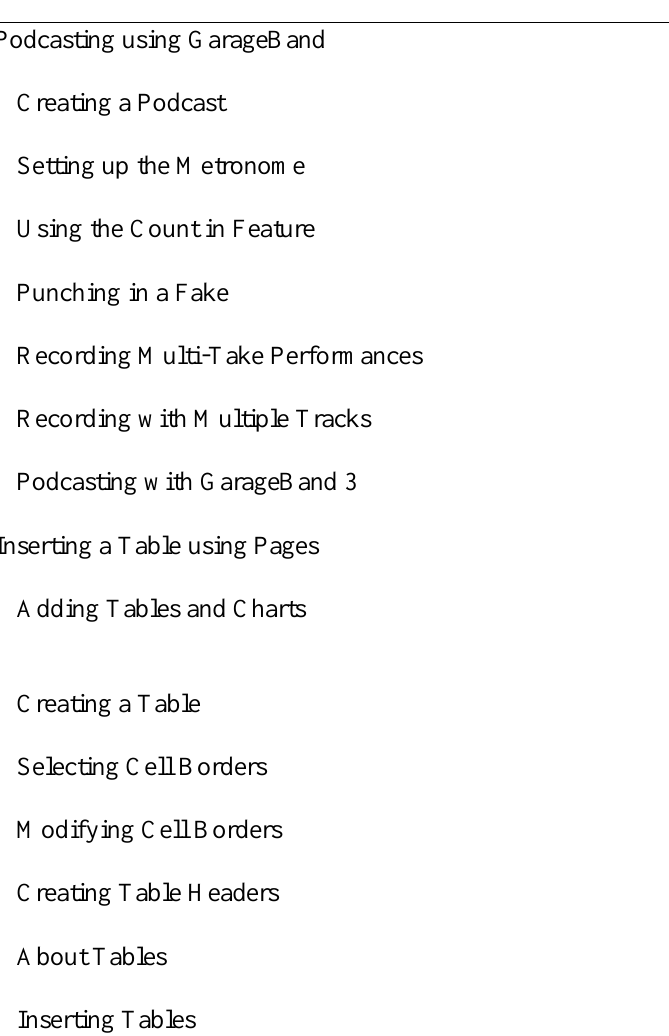
Inserting a Table using Pages Adding Tables and Charts Creating a Table